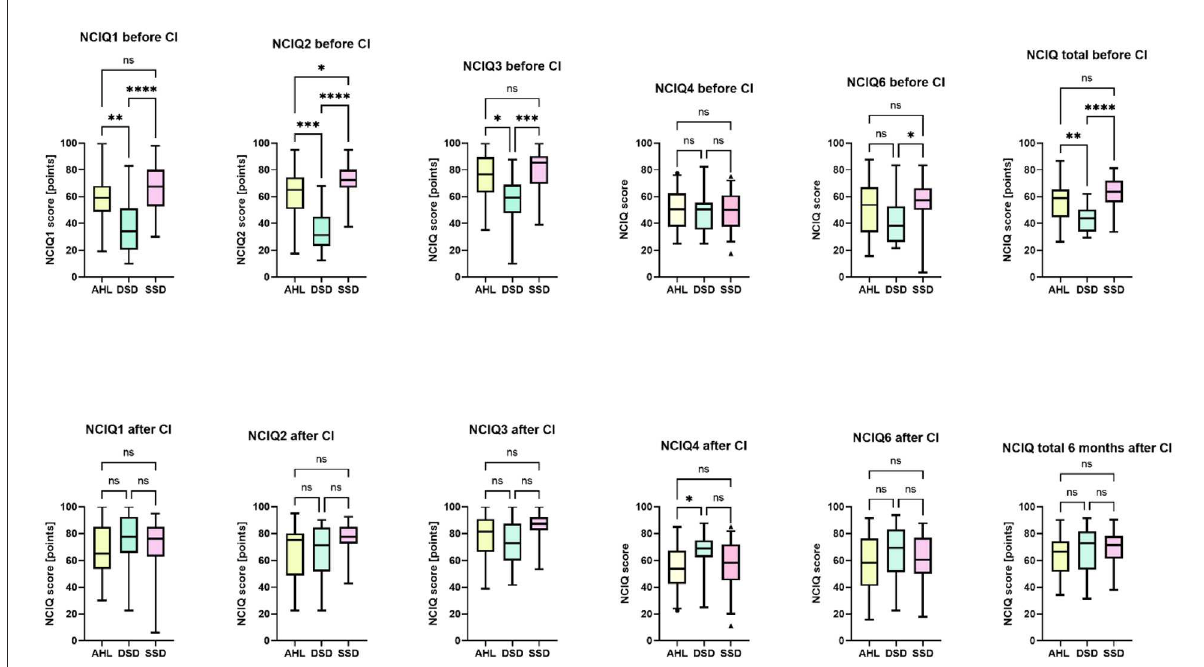
FIGURE3 Between-group differences in the health-related quality of life (NCIQ) before and after CI. The Kruskal-Wallis test with Bonferroni- correction indicated significant differences. * p < 0.05. ** p < 0.01. *** p < 0.001. **** p = 0.0. ns, not